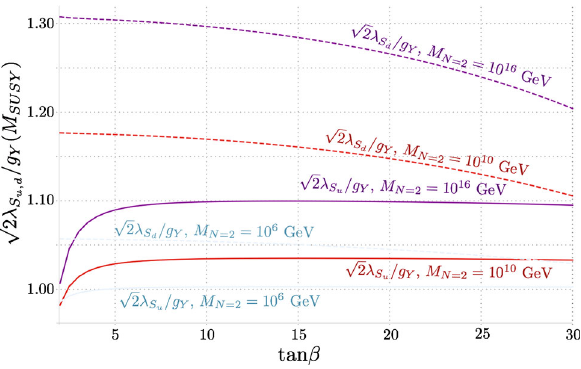
√ / g 2 λ S Y against tan u , d